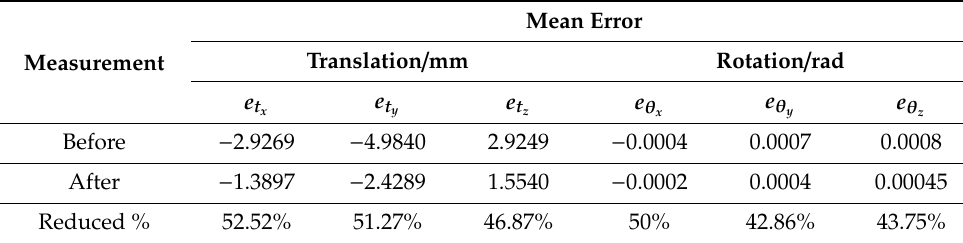
Figure 11. Comparison between before and after compensation in the experiment environment. Table 5. Mean error of the measurement system position accuracy.